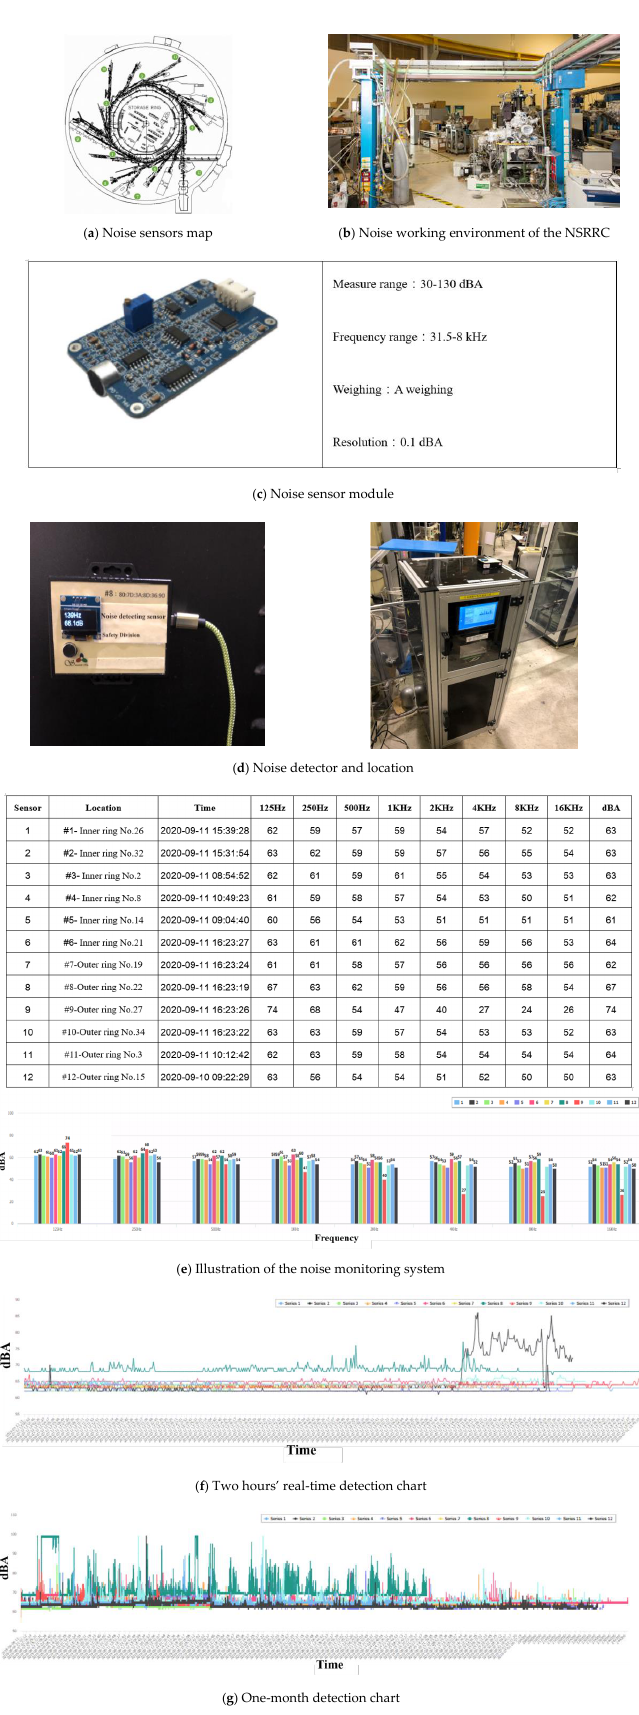
Figure 2. ( a ) Noise sensor map. ( b ) Noise working environment of the National Synchrotron Radiation Research Center (NSRRC). ( c ) Noise sensor module. ( d ) Noise detector and location. ( e ) Noise monitoring system illustrating. ( f ) Two hours’ real-time detection chart. ( g ) One-month detection